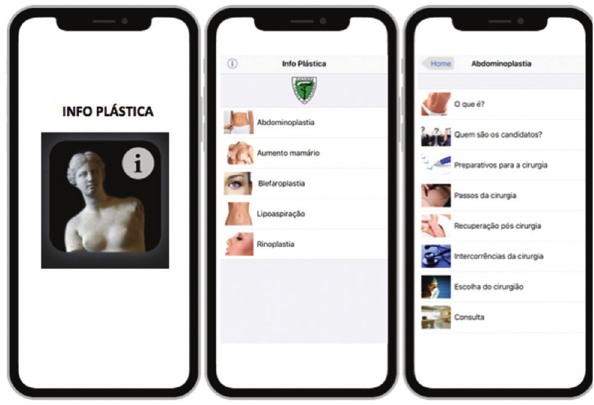
Figure 2 - App icon and home screen showing the procedures and their corresponding topics.